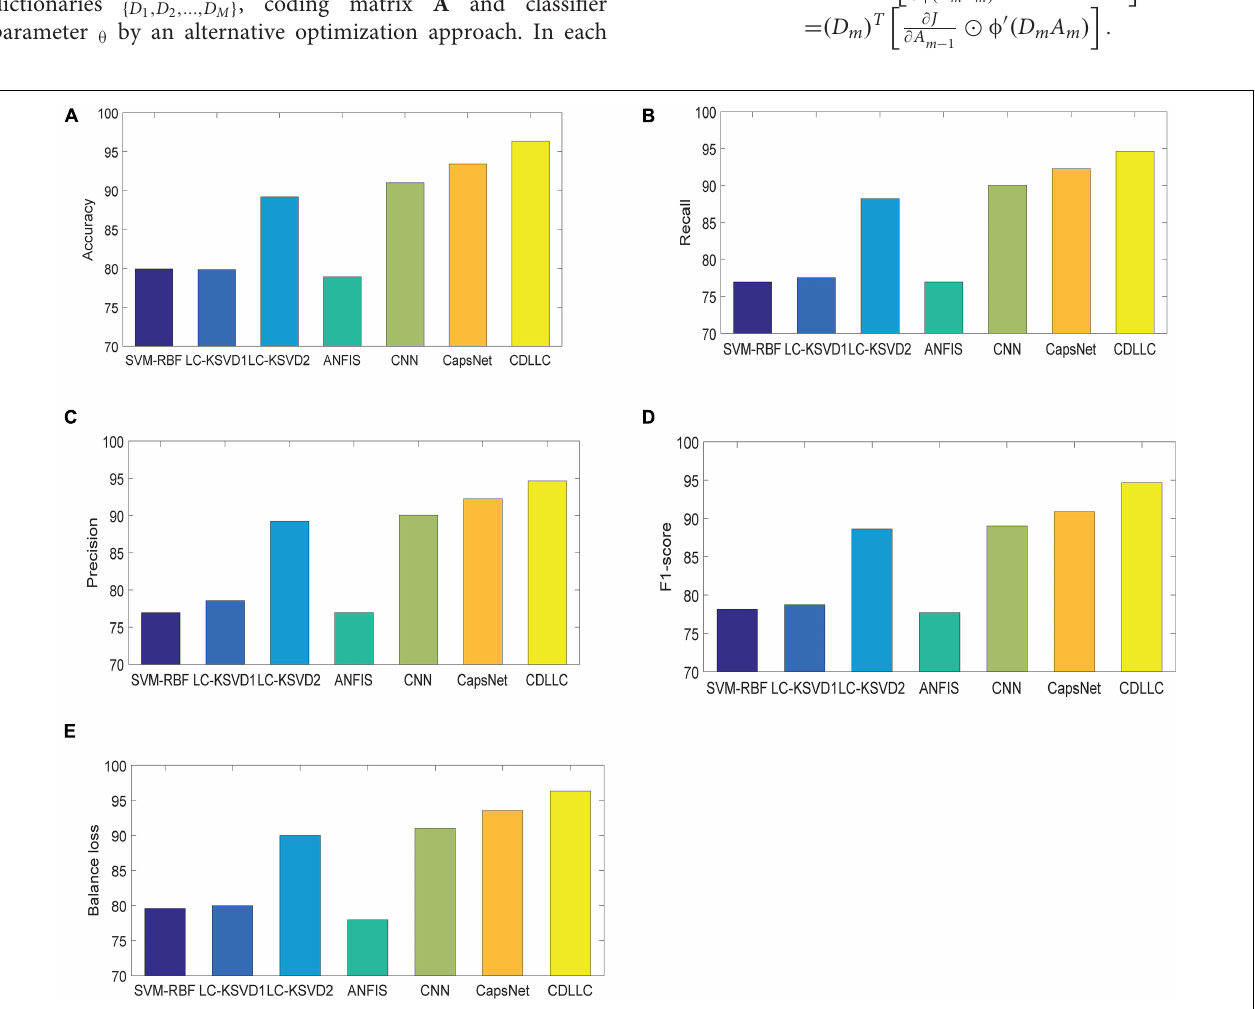
FIGURE 4 | Performance of CDLLC on the Cheng dataset: (A) accuracy, (B) recall, (C) precision, (D) F1-score, and (E) balance loss.